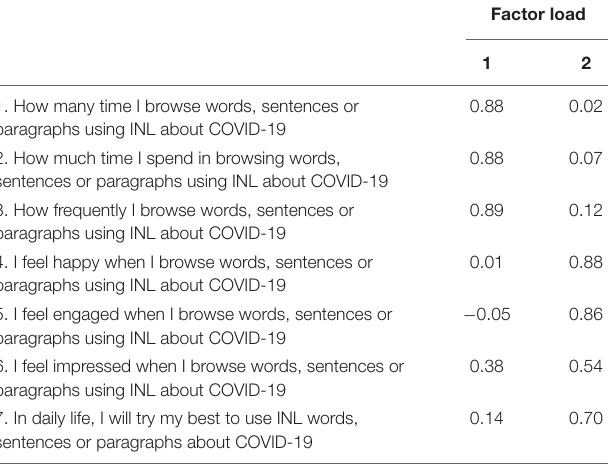
TABLE 2 | Results of EFA of the CINL scale before revision.